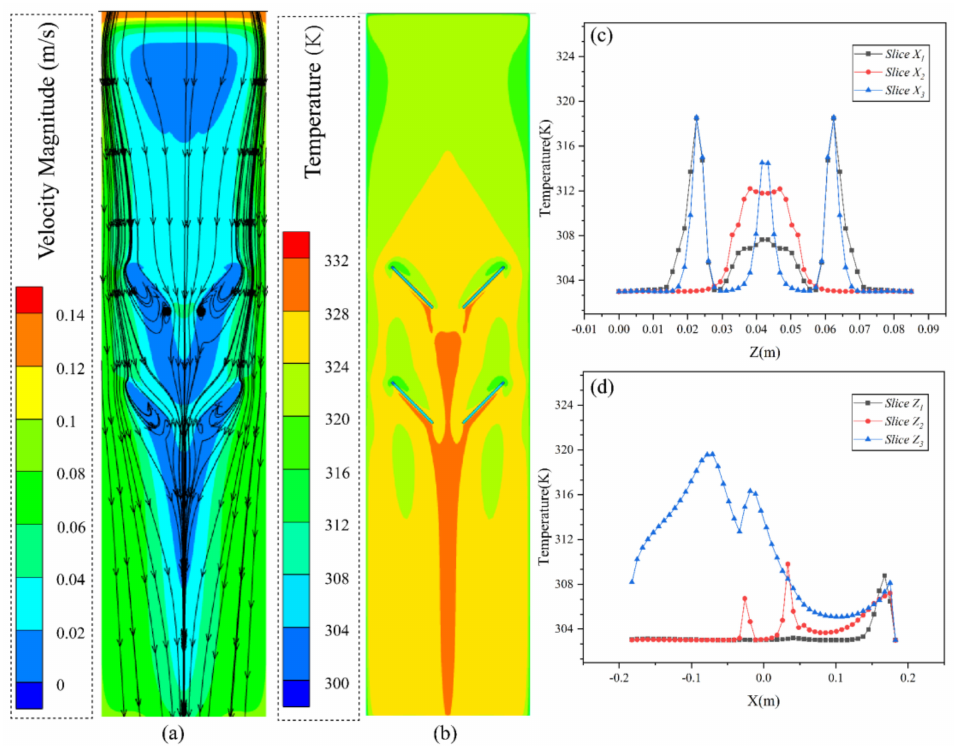
Figure 9. Diagrams of FD- 4 h under steady state conditions: ( a ) streamline diagram, ( b ) temperature contour diagram, ( c ) slice temperature diagram in X direction, ( d ) slice temperature diagram in Z direction.